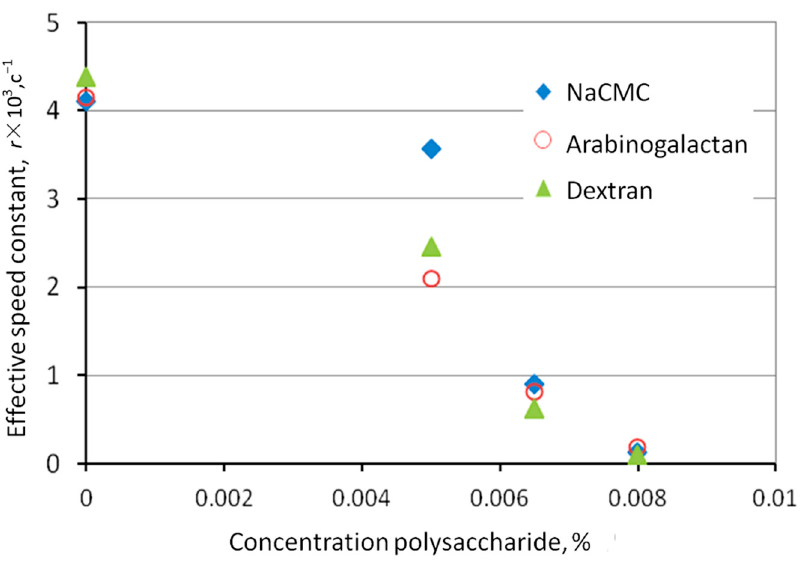
Figure 10. Dependence of hydrate formation rate constants in the presence of polysaccharides.